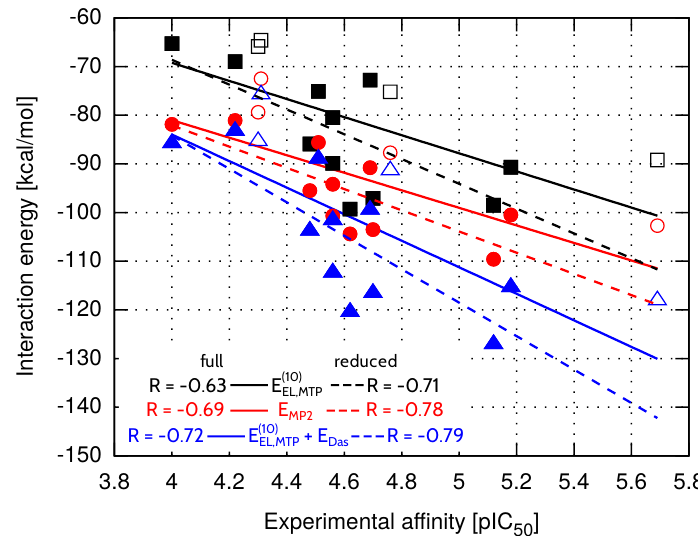
Figure 4. Total EphA2-inhibitor interaction energy at the selected levels of theory within the full (solid line) and reduced (dashed line) ligand sets. The reduced set of EphA2 inhibitors consists of the compounds shown with full